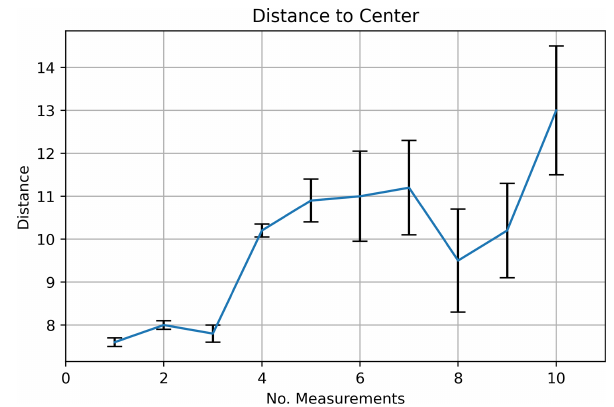
Figure 22. Measurement distance to center, POMCPOW with ac- tion constraints, single body with variable location. The plot shows the average distance between the measurement location and the mineralization center for the measurements at each time step. 1 stan- dard error bars are also presented.